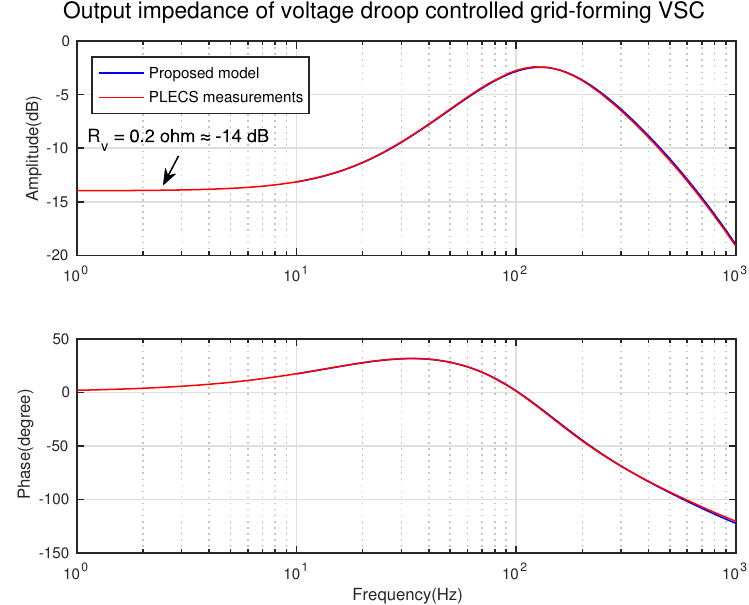
Figure 6. The output impedance validation of voltage droop controlled grid-forming